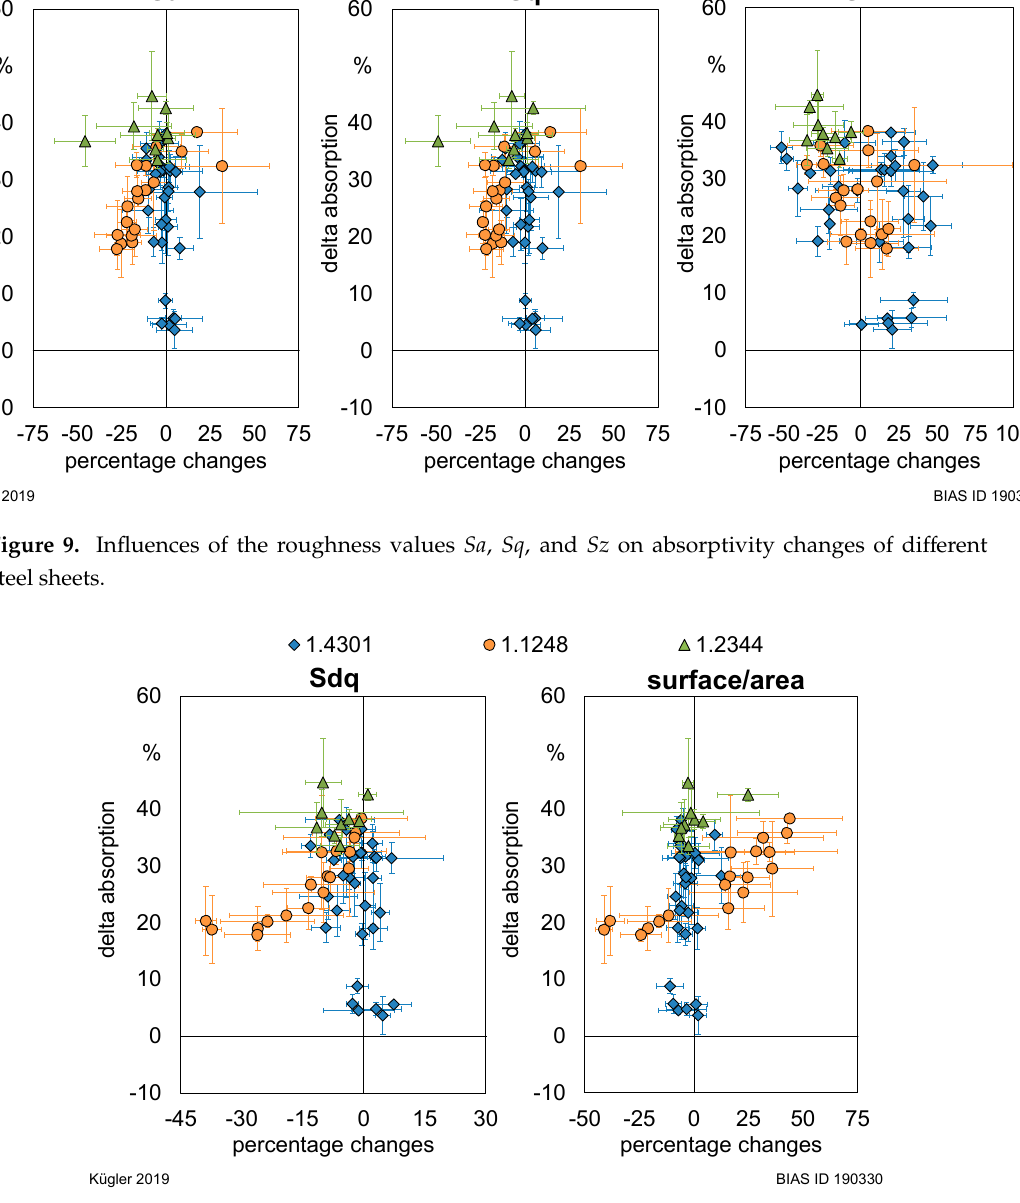
Figure 10. Influences of the roughness value Sdq and the topography factor surface/area on absorptivity changes of different steel sheets.